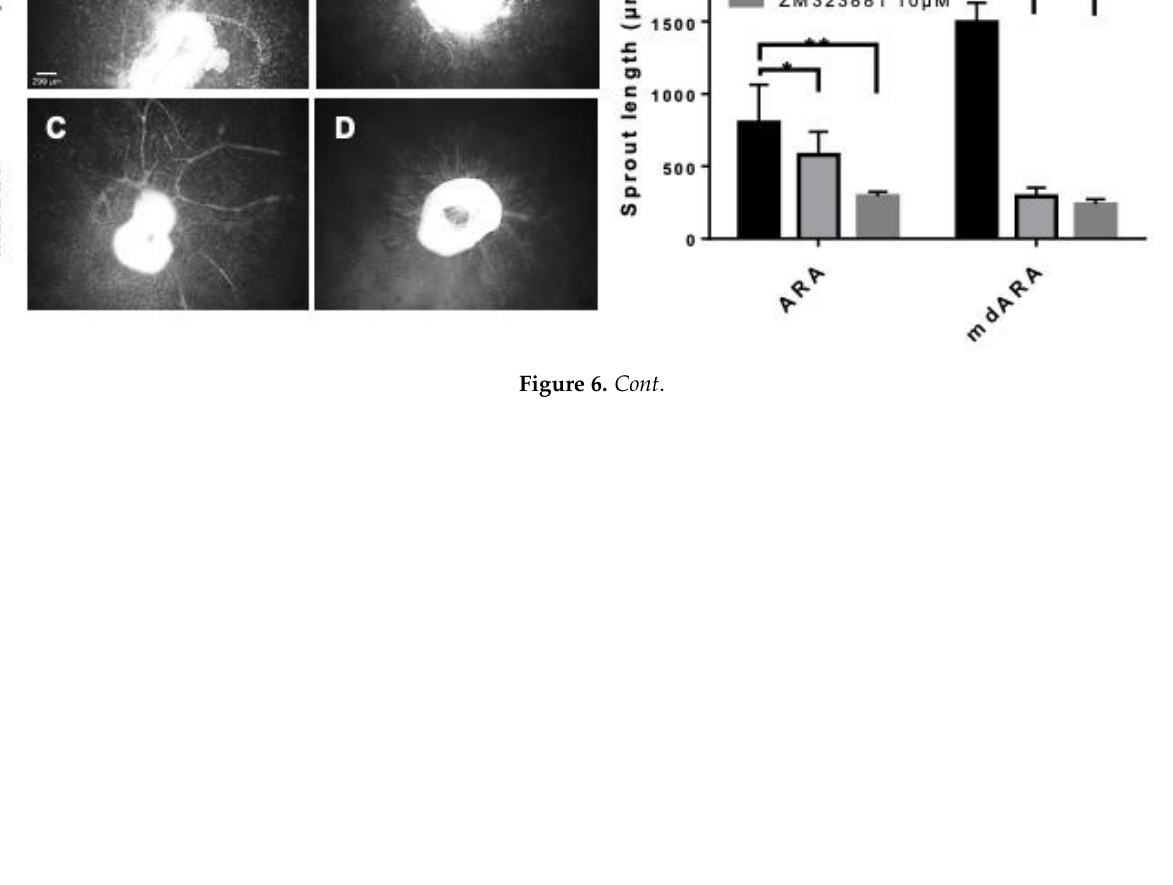
Figure 6. Vascular adventitial cells affect response to VEGF-R inhibition. ZM323881 reduces vascular sprouting less effi- ciently in ARA with the adventitia in place ( A , B ) than in mdARA ( C , D ). The quantification of sprouting ( E ). Treatment with ZM323881 reduced the migration of cells towards the MCTS in the Adv(+) experiments ( F vs. H ), but had little effect on sprouting at the non-tumor side ( G vs. I ). In the Adv(-) experiments, ZM323881 completely blocked capillary sprouting ( F’ – H’ versus G’ – I’ ). Whole mount staining of CD34 + cell in red and NG2 + cells in green ( J – K ), under hypoxia, at day 14. Error bars indicate SD. * p ≤ 0.05, ** p ≤ 0.01, **** p ≤ 0.0001 .